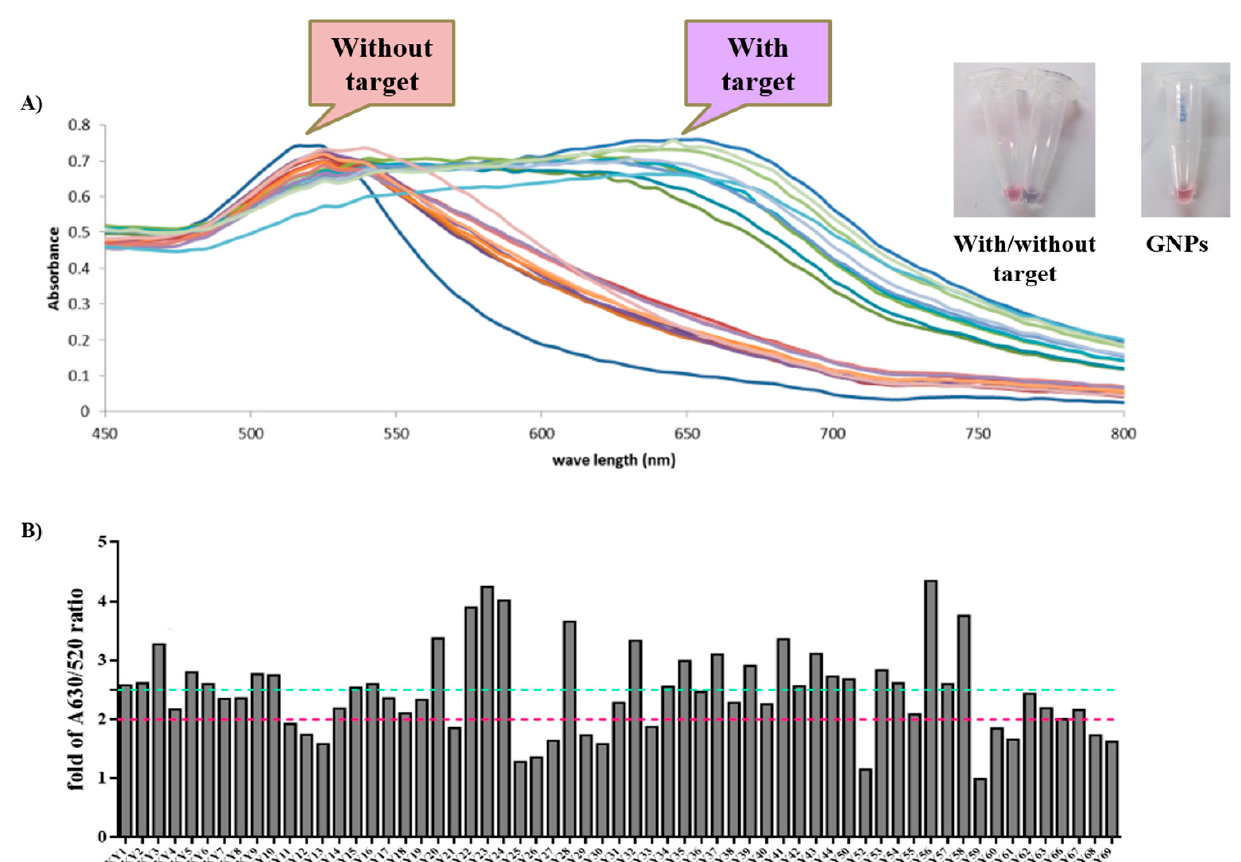
Figure 1. GNPs-based colorimetric results. ( A ) The spectra of HIV-1 RTs in the presence and absence of KY DNA aptamers. Each color line represent for GNPs-based colorimetric assay in with or without HIV-1 RT. ( B ) Fold change of DNA aptamers when complexed with KY HIV-1 RT. Green line at cutoff 2.5-fold change and pink line at cutoff 2.0-fold change.